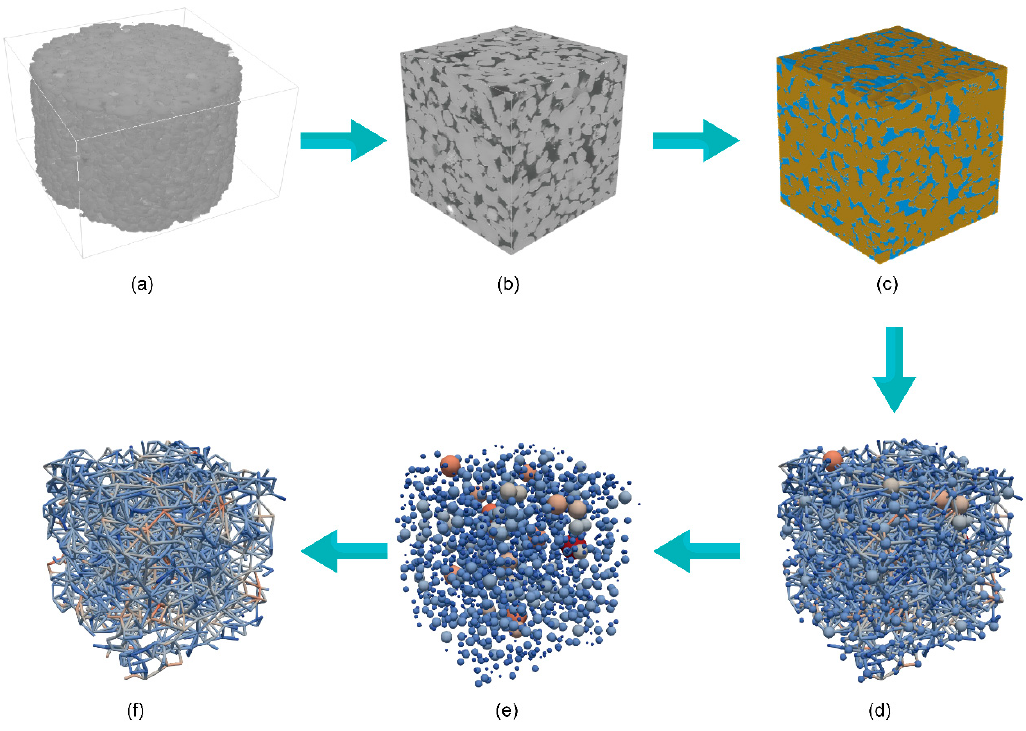
Figure 3. Workflow to generate the pore network model (PNM). ( a ) The original 3D volume; ( b ) the subvolume; ( c ) the binary subvolume; ( d ) the full PNM, including nodes and links; ( e ) nodes in the PNM; and ( f ) links in the PNM.